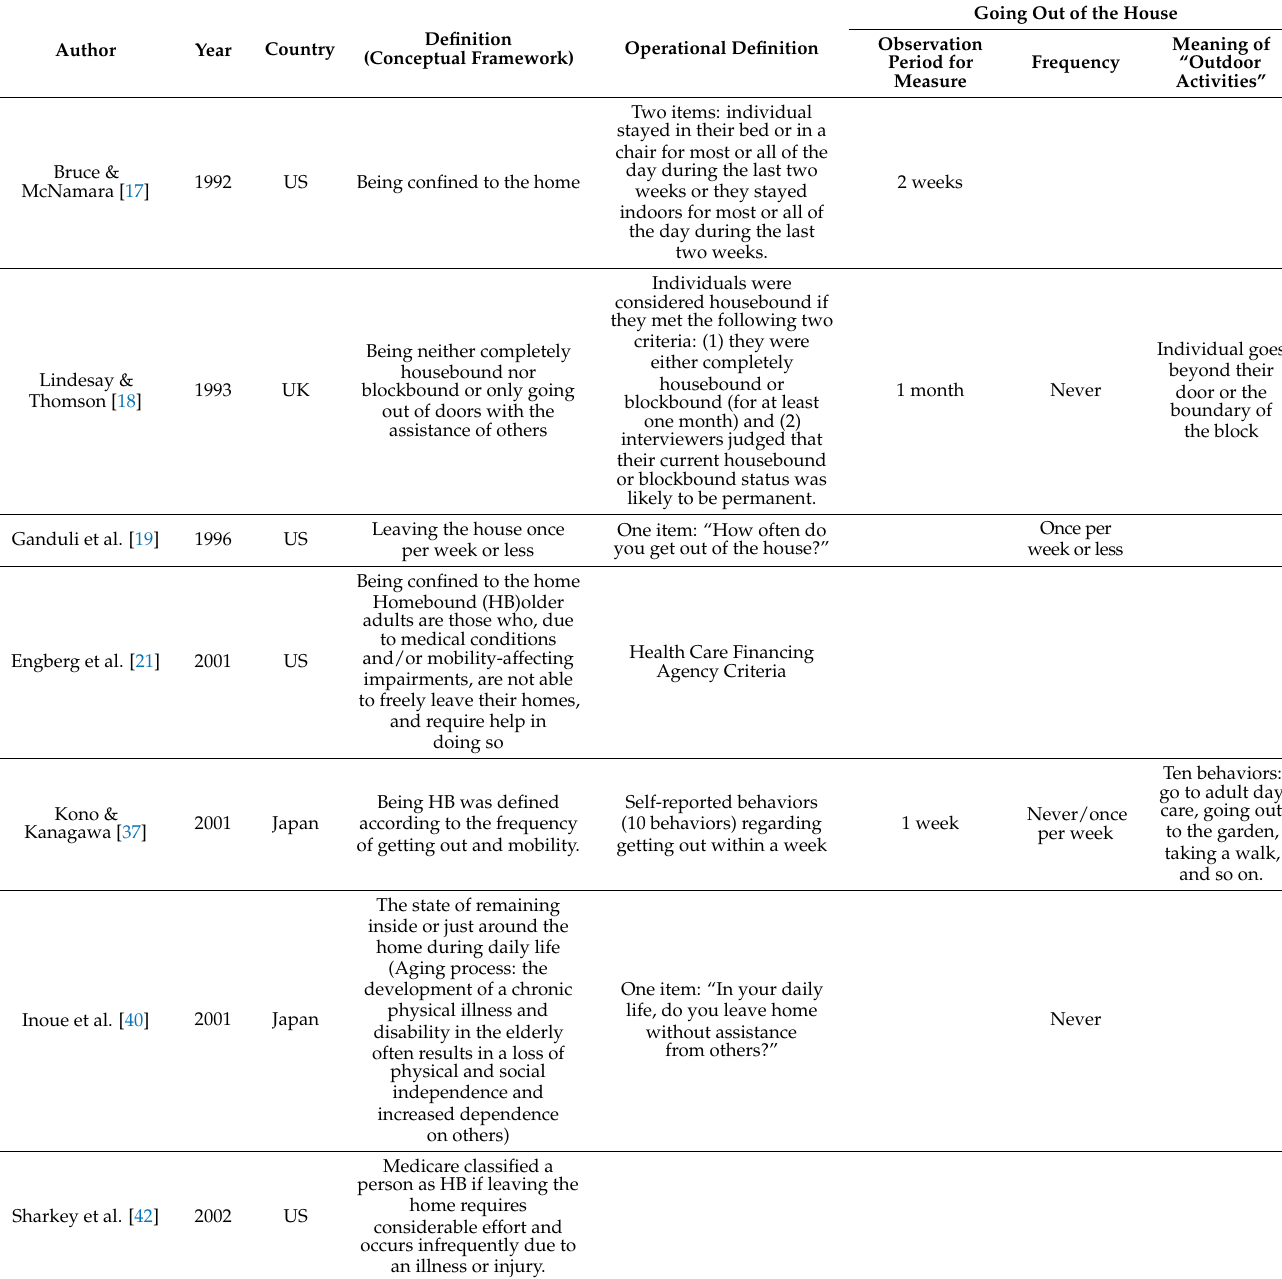
Table 3. Definition of HB and the applied theoretical